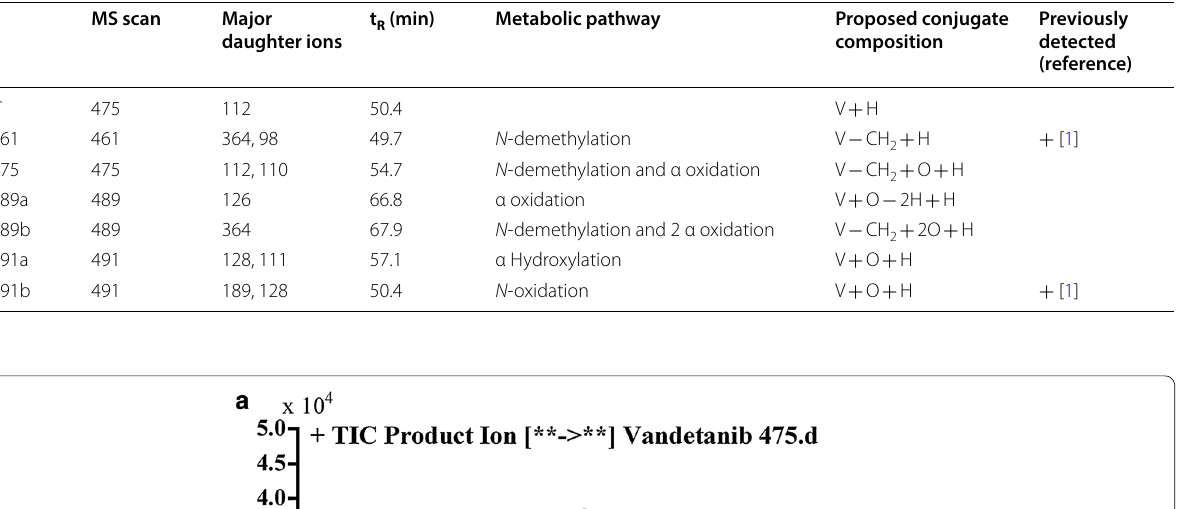
Table 3 Phase I metabolites of Vandetanib using MS scan and PI scan